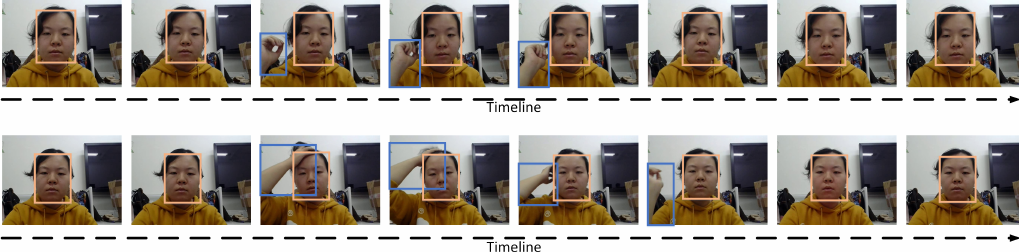
Figure 1. Two image sequences of the same person when watching an unstressed video clip ( upper ) and stressed video clip ( lower